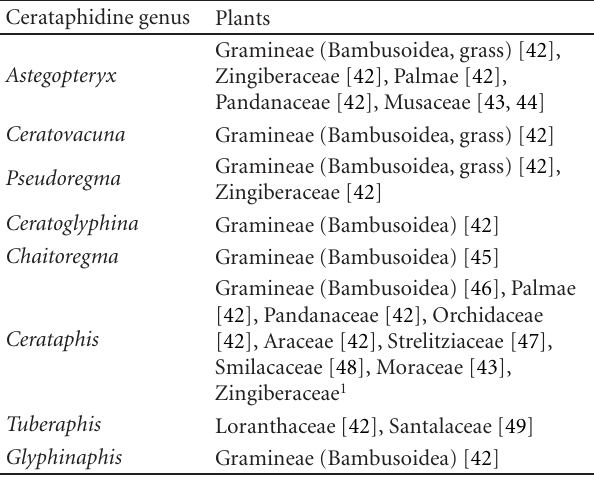
Table 2: Secondary hosts of